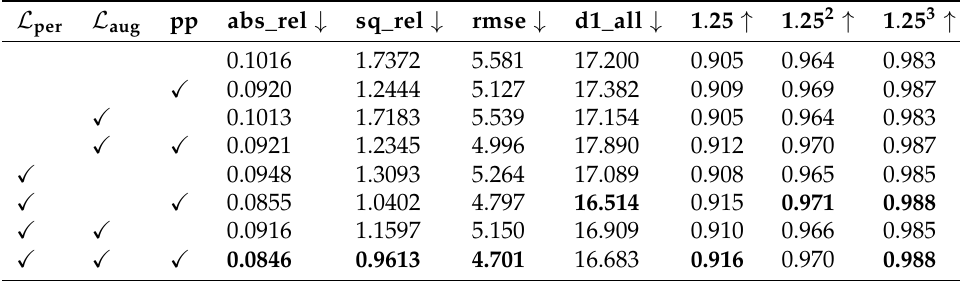
Table 5. Ablation study of different components in